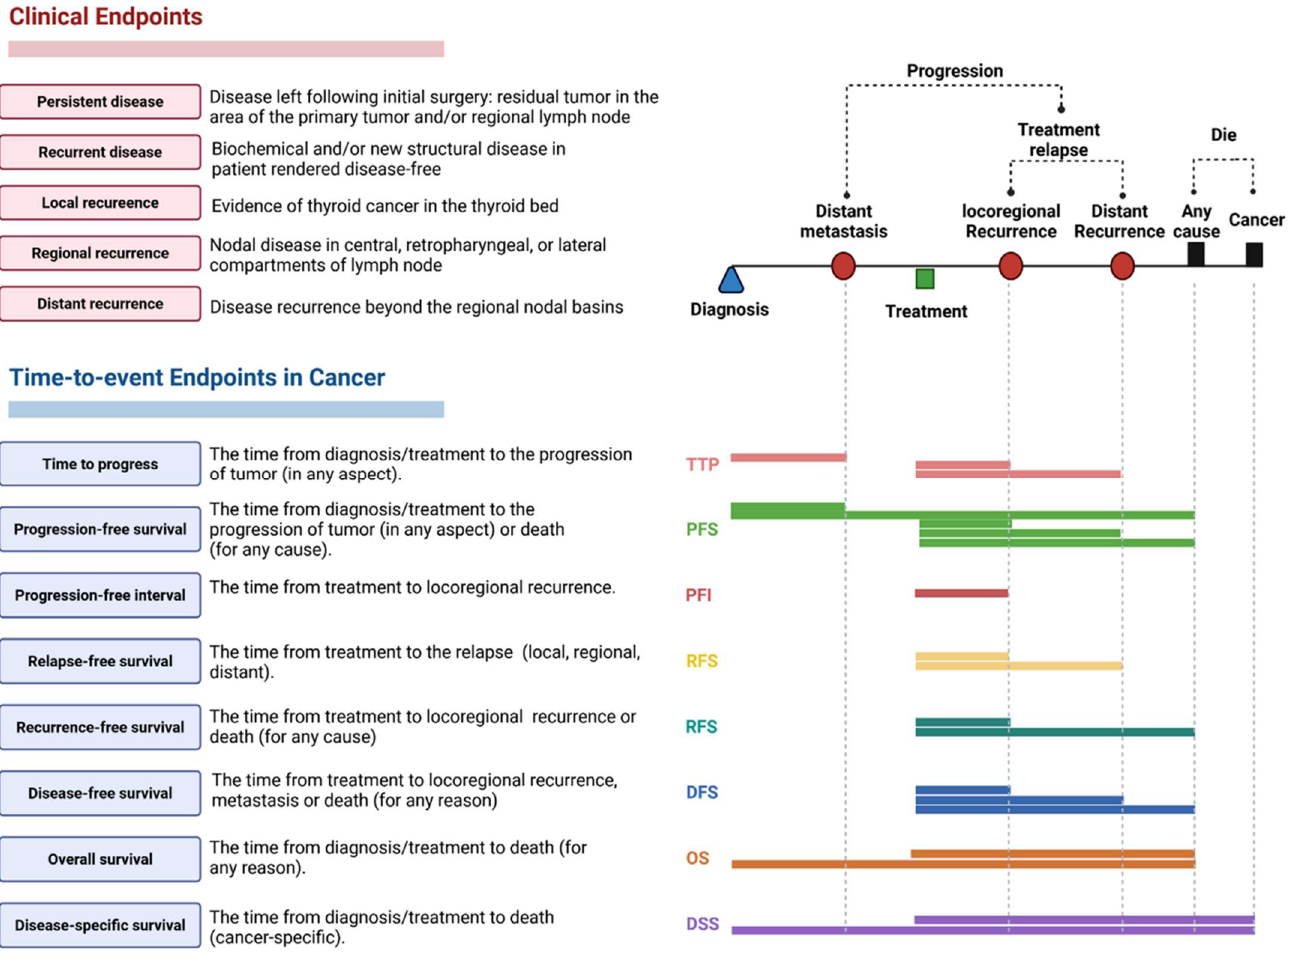
Figure 1. Time-to-event endpoint metrics for survival analysis; definition of the assessment of time-to-event endpoints and clinical outcomes in cancer.